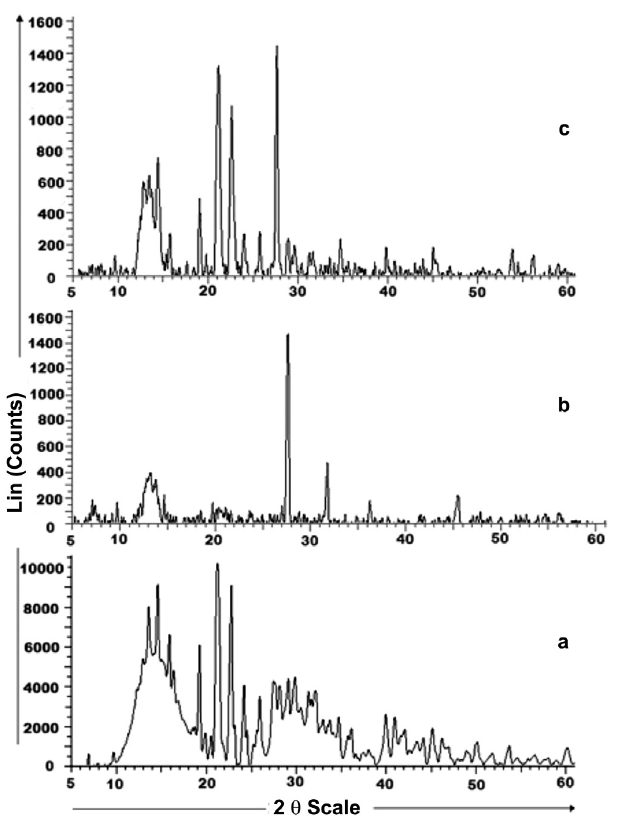
FIGURE 5 - Powder X-ray diffraction patterns ( a ) Raloxifene HCl, ( b ) HPMC E5 LV and ( c ) Solid dispersions prepared by the microwave induced fusion method with an exposure time of 6 min.